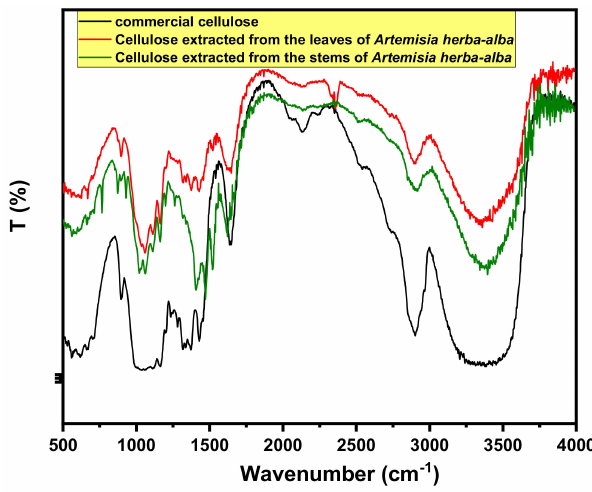
Figure 1. FT-IR spectra of the biopolymer